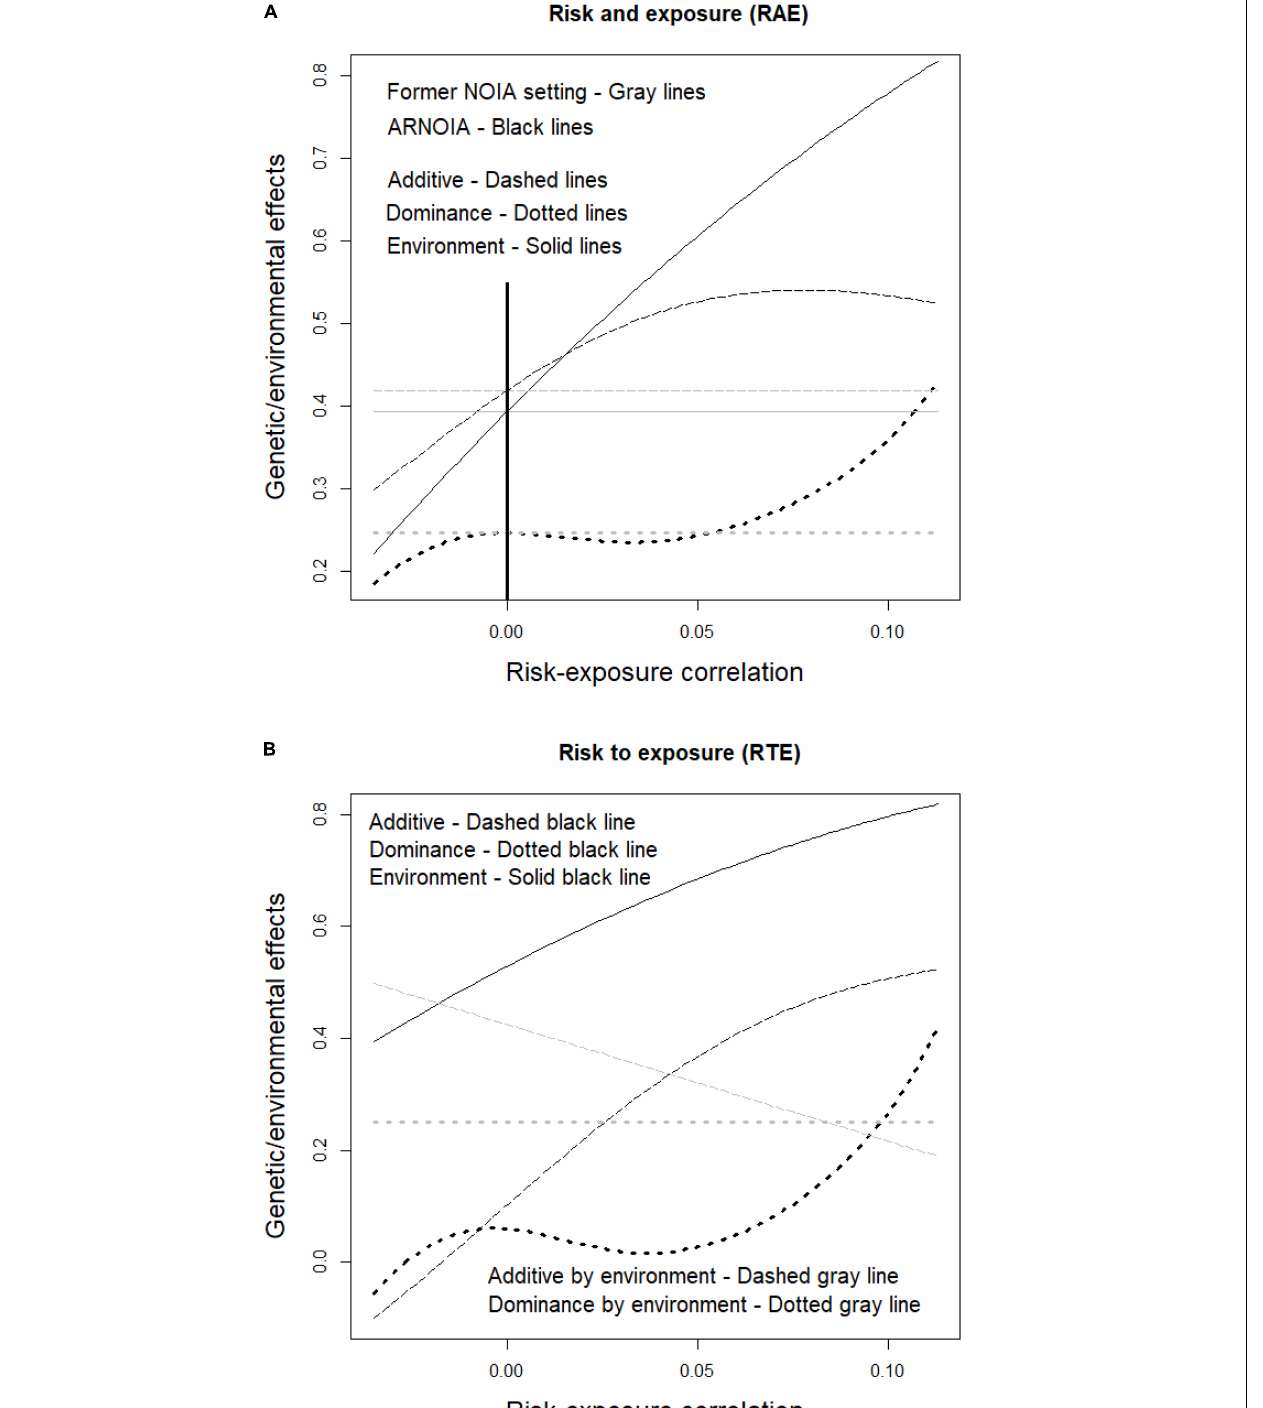
Frontiers in Genetics |